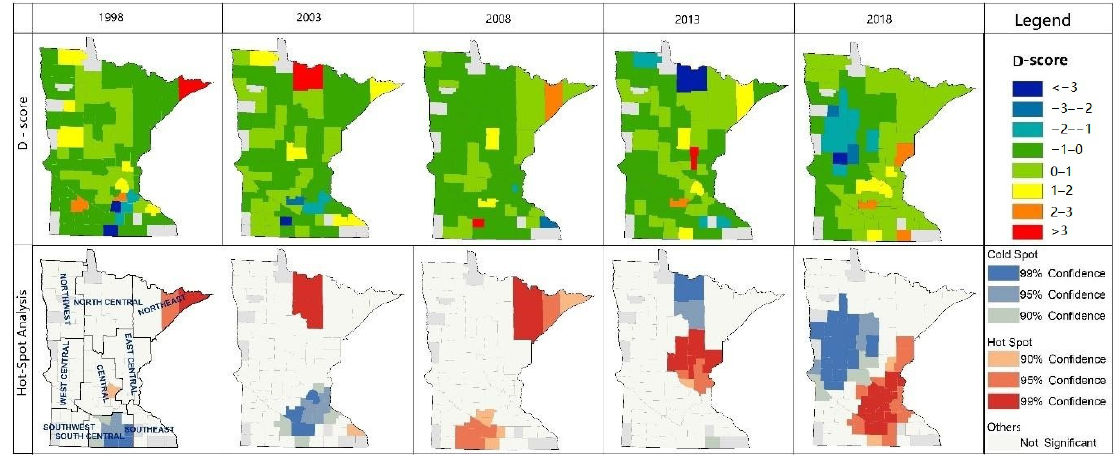
Figure 12. D-score distribution and spatial clustering.